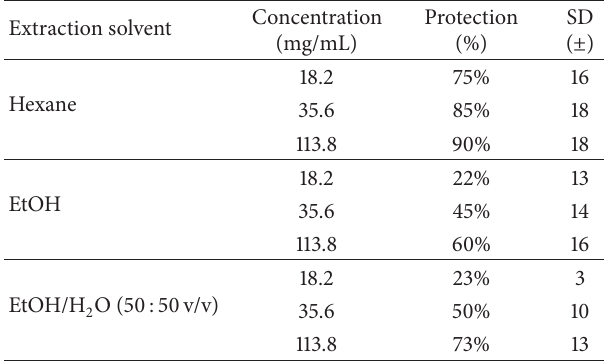
Table3: Percentageofprotectionagainstmosquitoes( A. aegypti )in relation to the dose of the different B. orellana seed extracts